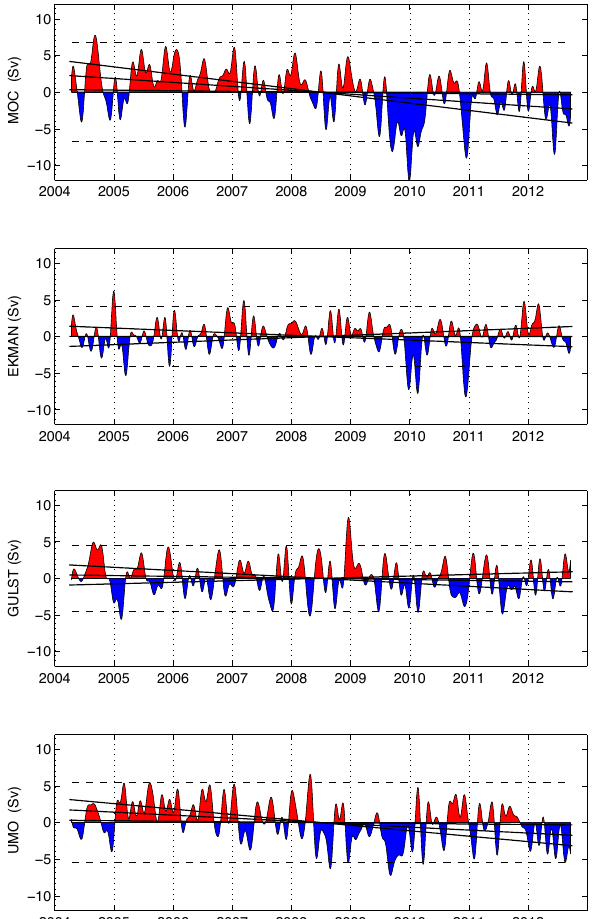
Fig. 3. Anomalies (positive is northward) relative to mean annual cycle. From top to bottom: MOC, Ekman, Gulf Stream, and UMO. A 45-day low-pass filter was applied to each time series. For each time series horizontal dashed lines show ± 2 standard deviations and the solid black lines show the average trend ± 1.64 standard errors (i.e. 90% confidence limits).